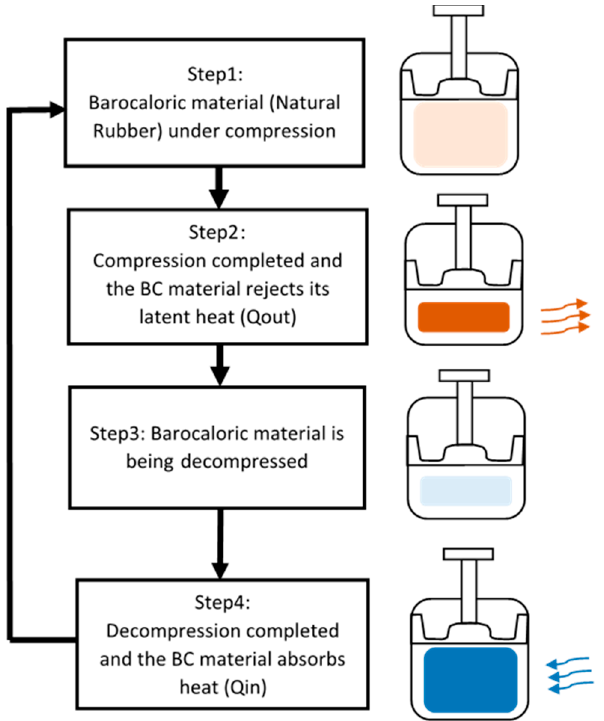
Figure 6. Schematic showing the basic working principle of Barocaloric